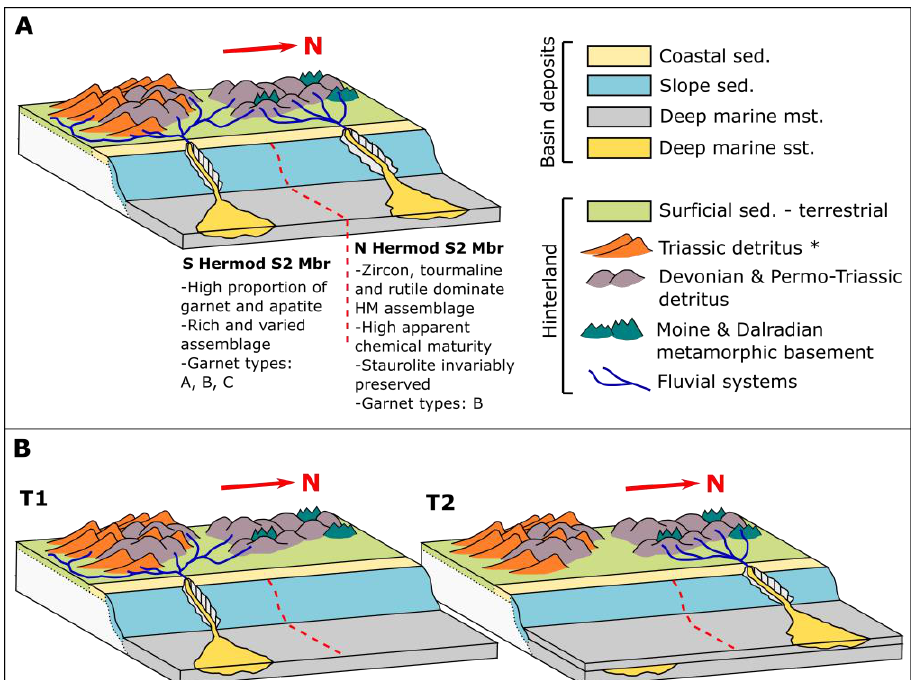
Figure 14. Alternative models for deposition of Hermod S2 Mbr sandstones. ( A ) Contemporaneous or near-contemporaneous deposition from distinct point sources. ( B ) Stratigraphic evolution of provenance and a northward shift of depocenter. * Triassic detritus specifically equivalent to Otter Bank & Foula Fms, bearing garnet assemblages rich in types A and C garnets.